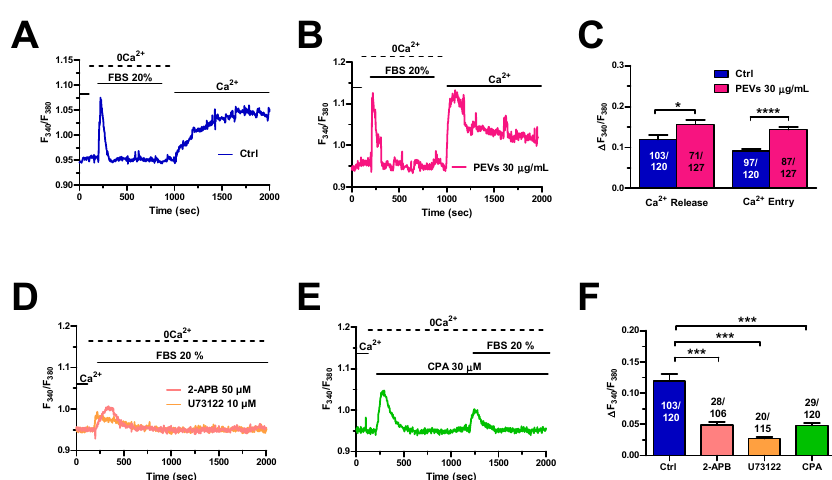
Figure 5. Long-term exposure to PEVs enhances FBS-induced ER Ca 2+ mobilization and SOCE. ( A ). A transient increase in [Ca 2+ ] i was evoked by 20% FBS under 0Ca 2+ conditions in control (Ctrl) cells. FBS was then removed from the recording bath, while extracellular Ca 2+ was restored to the perfusate to measure SOCE. ( B ). Pre-treatment of MDA-MB-231 cells with PEVs (30 μ g/mL, 24 h) increased the endogenous Ca 2+ mobilization and the SOCE induced by 20% FBS. ( C ). Mean ± SEM of 20% FBS-induced intracellular Ca 2+ release and SOCE in control and treated cells. **** indicate p < 0.0001 and * indicates p < 0.05. ( D ). The Ca 2+ response to 20% FBS, under 0Ca 2+ conditions, was inhibited by U73122 (10 μ M, 30 min), a selective PLC blocker. Moreover, the Ca 2+ signal was inhibited by blocking InsP 3 Rs with 2-APB (50 µ M, 30 min). ( E ). Emptying the ER with CPA (30 µ M, 20 min) prevented (not shown) or significantly reduced an FBS-induced increase in [Ca 2+ ] i . ( F ) . Mean ± SEM of the amplitude of 20% FBS-evoked Ca 2+ peak under the designated treatments. *** indicate p < 0.001.